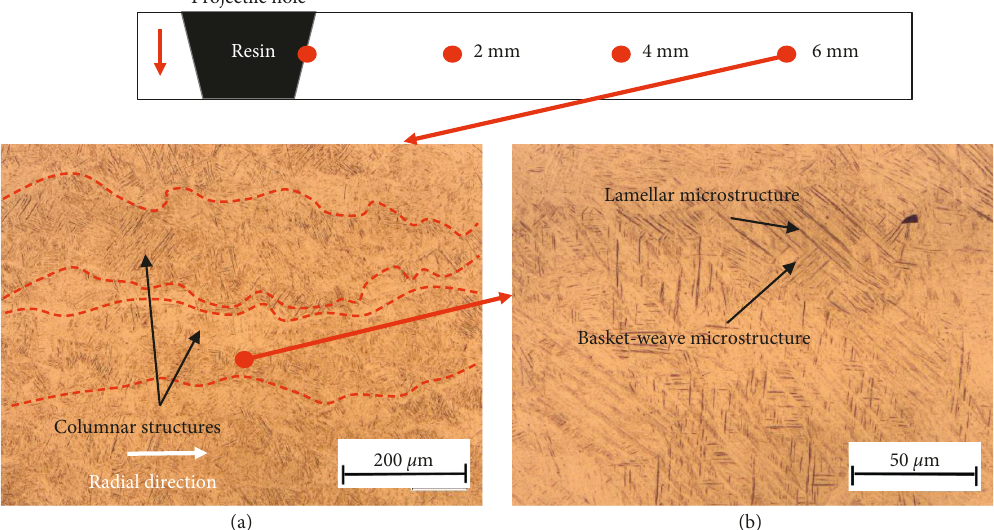
Figure 19: (a) Optical micrograph and (b) higher magnification optical micrograph, both at 6mm from the edge of the projectile hole through a 10mm thick